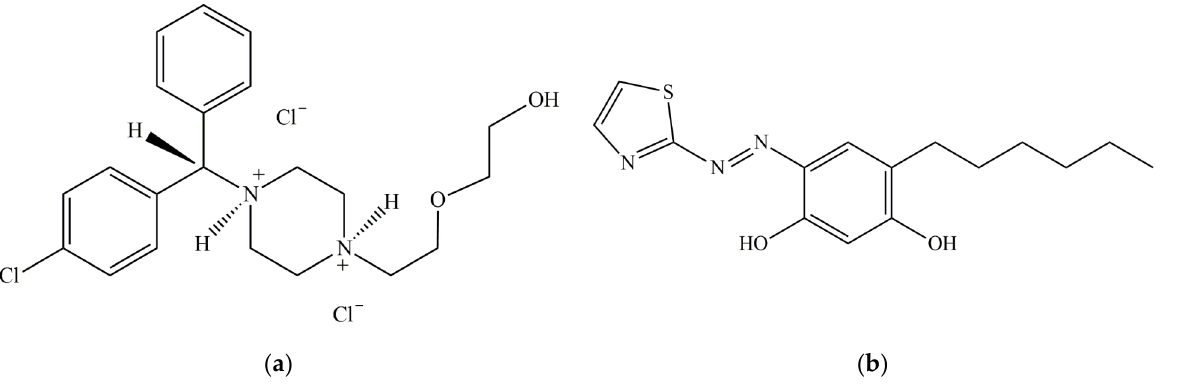
Figure 1. Molecular structure of hydroxyzine dihydrochloride (HZH) [2,4,26] ( a ) and 6-hexyl-4-(2- Figure thiazolylazo)resorcinol (HTAR) [24,25] ( b ).